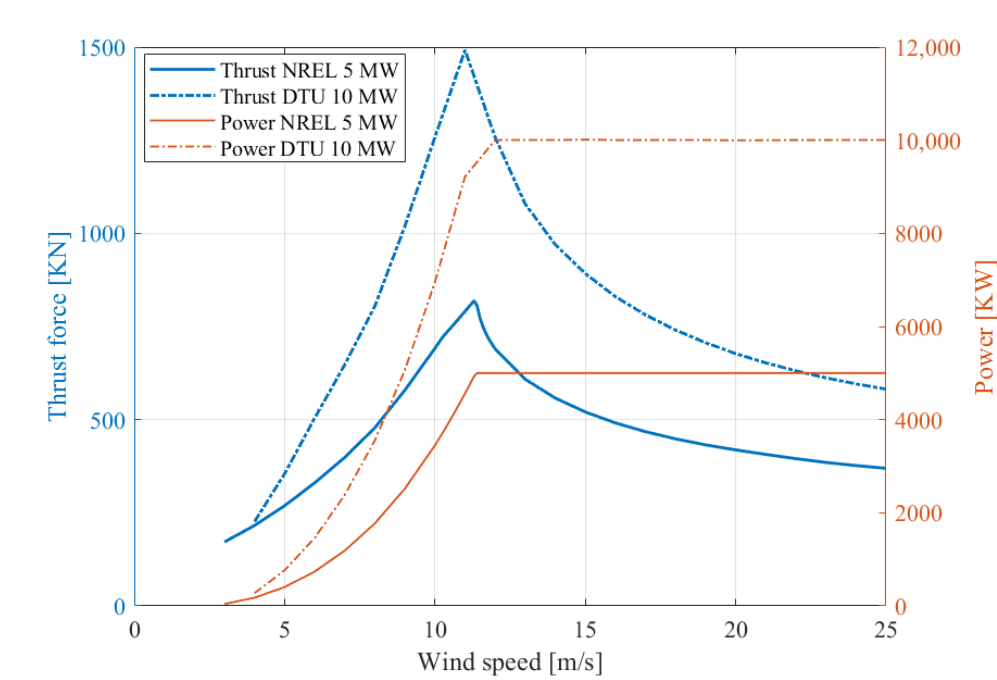
Figure 7. Thrust and power curves for NREL 5 MW and DTU 10 MW wind